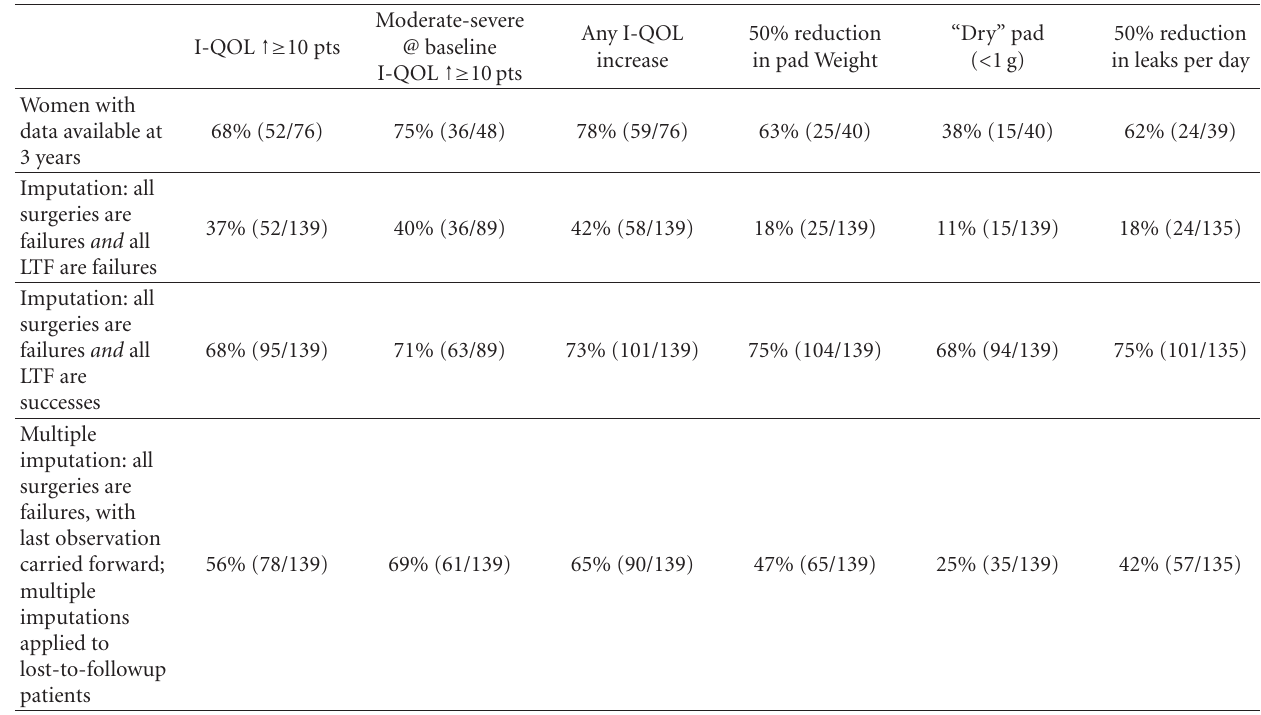
Table 11: Analysis of results at 36 months, using di ff erent assumptions about outcomes for patients with missing